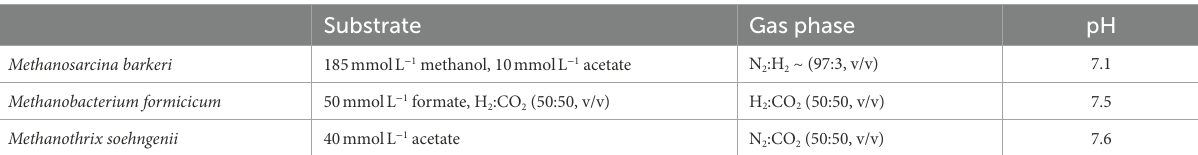
TABLE 2 Growth conditions for methanogenic cultures, pH values adjusted according to literature (Neil and James, 1980; Huser et al., 1982; Neil et al., 1982; Touzel et al., 1988).